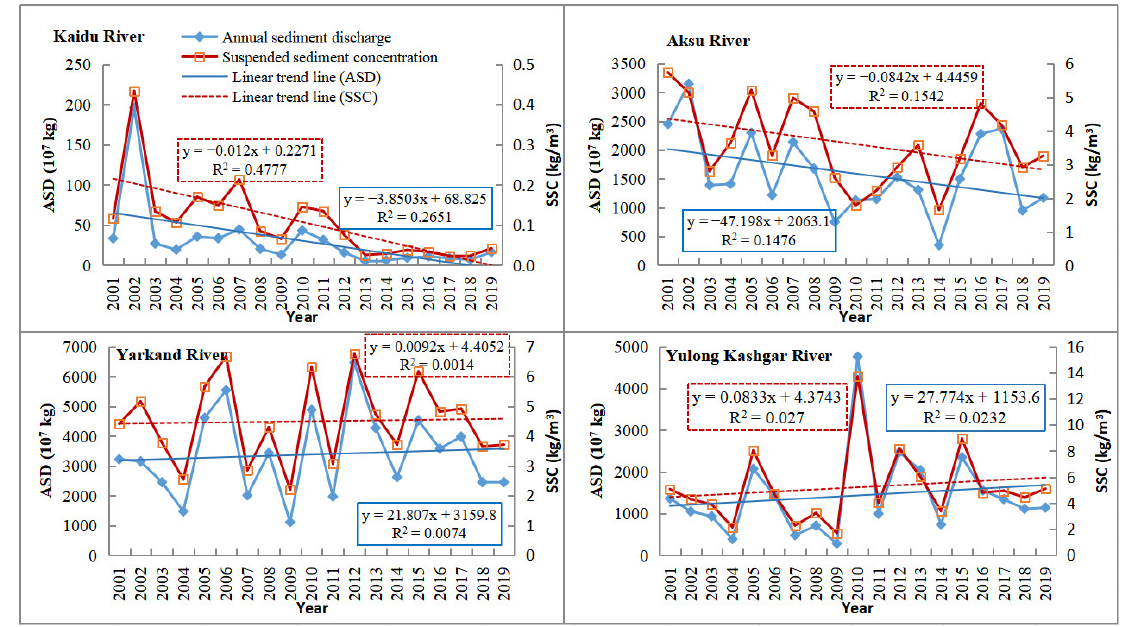
Figure 2. Annual sediment discharge and suspended sediment concentration at the main rivers of the TRB.